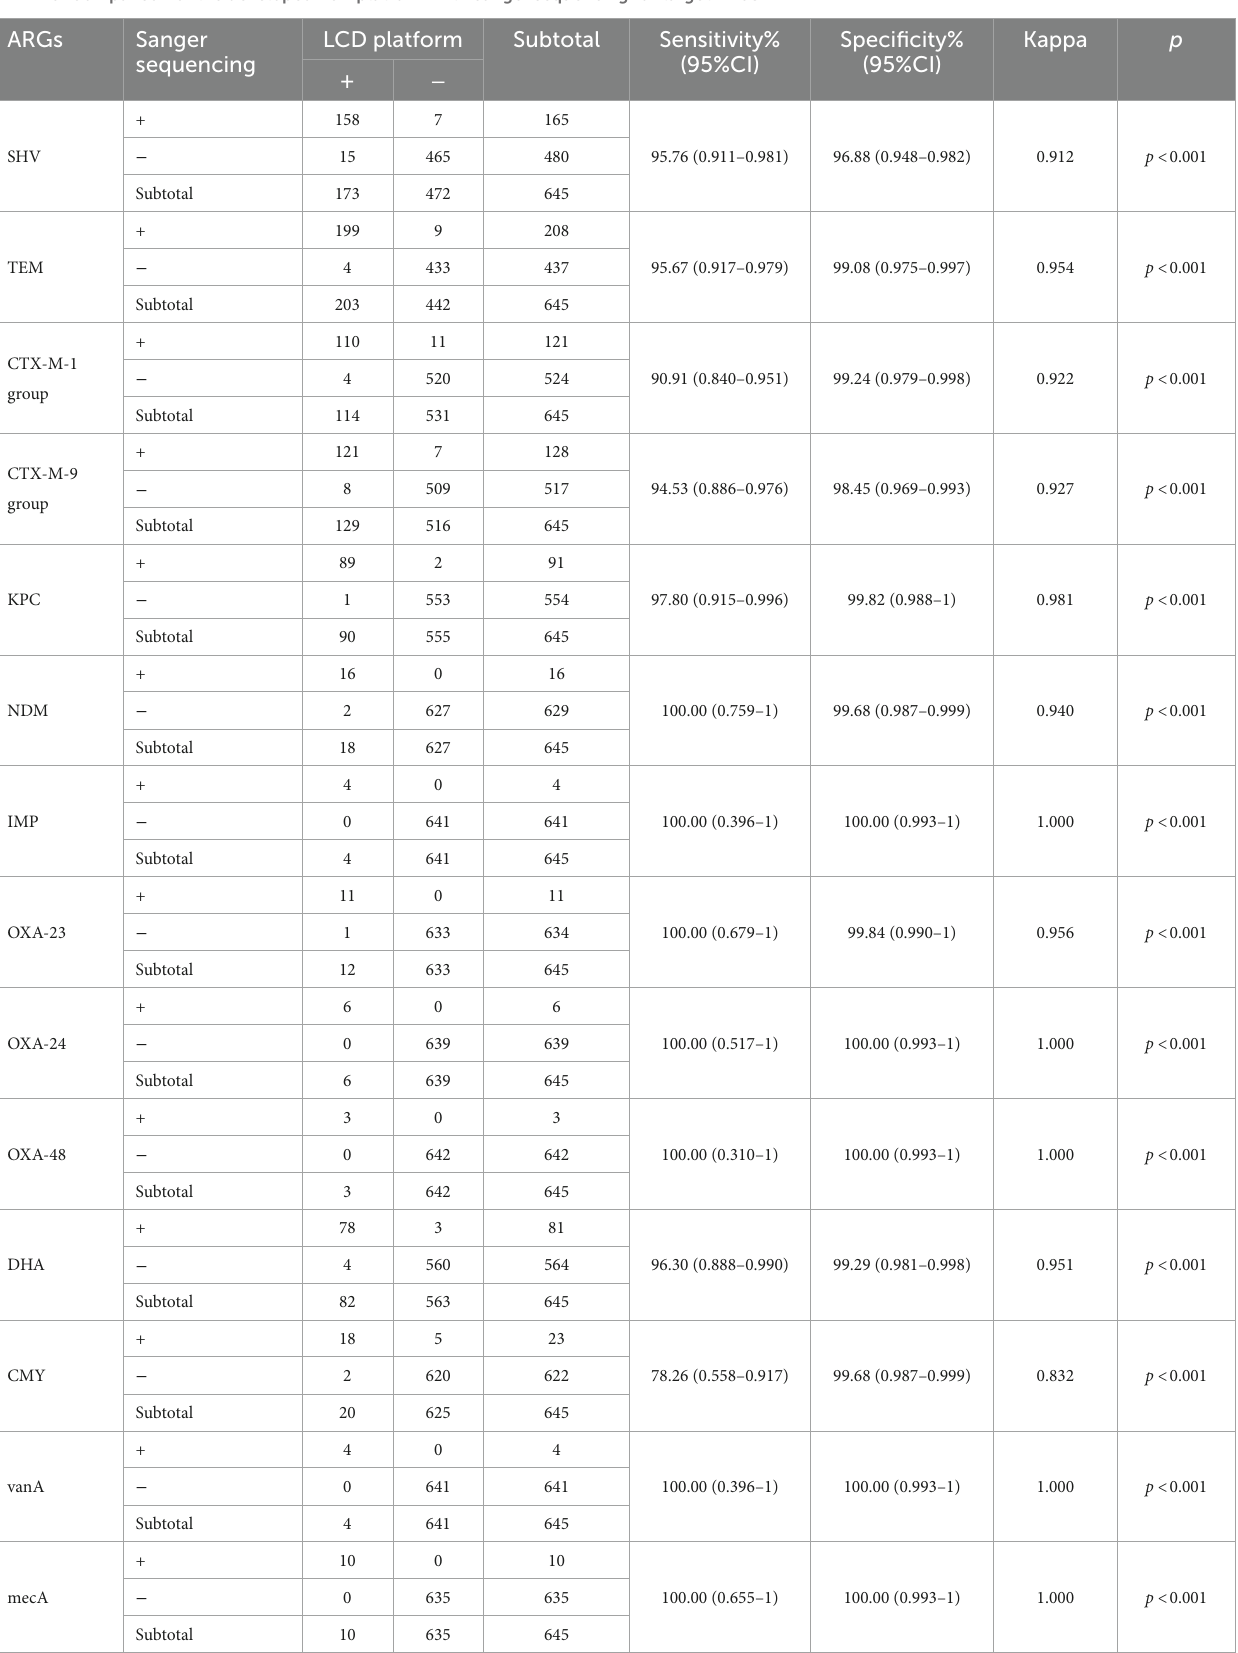
TABLE 3 Comparison of the developed LCD platform with Sanger sequencing for target ARGs. ARGs Sanger